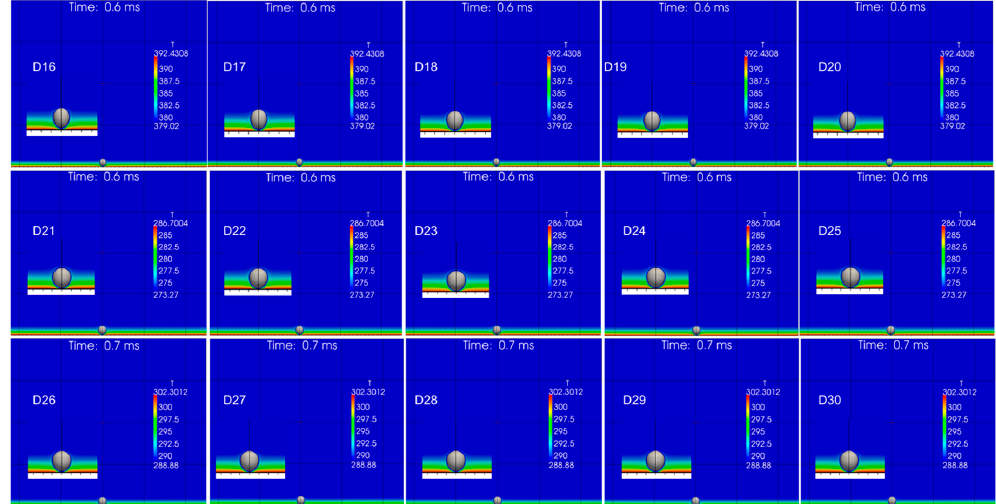
Figure 25. Spatial evolution of generated bubble at the time of detachment for each case of the Series D parametric numerical simulations, with the 5 bar ambient pressure condition.